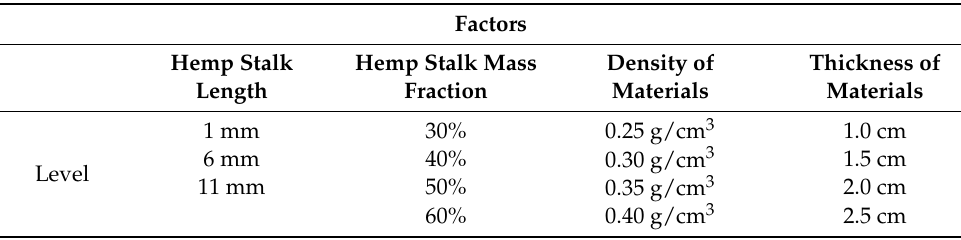
Table 1. The parameters for the preparation of the sound-absorbing composite materials to be optimized.